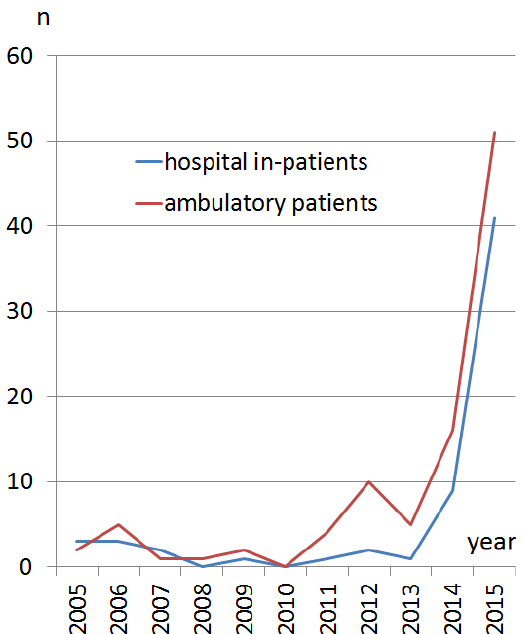
Figure 1. Number of refugee children treated at our department from January 2005 until December 2015. The blue line represents inpatients, the red line represents ambulatory patients. A sharp rise is evident in the years 2014 and 2015.